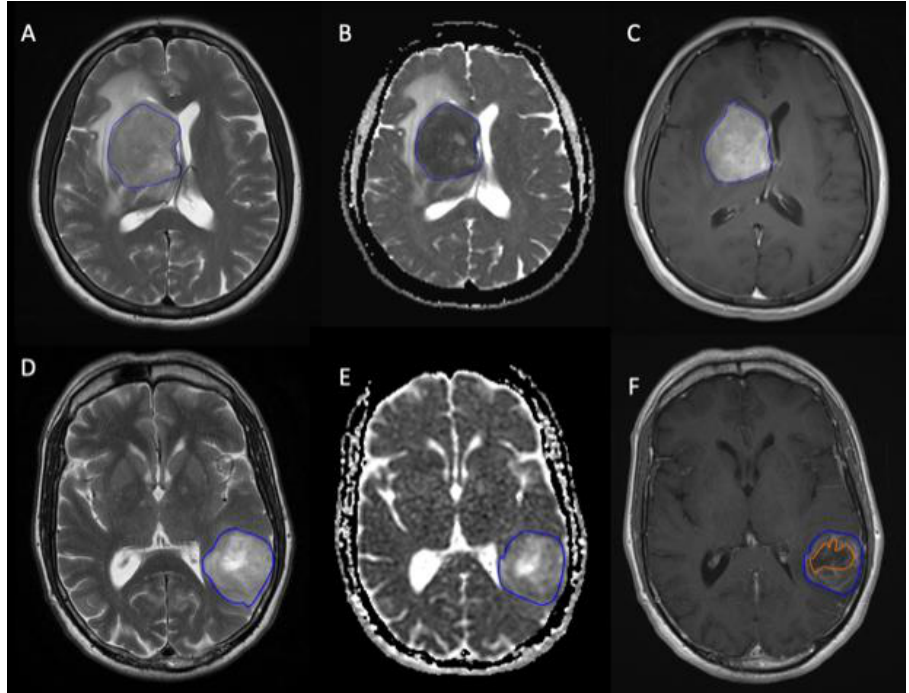
Figure 2. Example segmentations. T 2 , ADC maps, and T 1 CE images in two patients with PCNSL ( A – C ) and glioblastoma ( D – F ) demonstrating MRTA regions of interest (blue outlines). In the glioblastoma patient, the segmentation, excluding necrosis, is additionally shown (blue and orange outlines). ADC = apparent diffusion coefficient; PCNSL = primary central nervous system lymphoma; MRTA= magnetic resonance texture analysis.